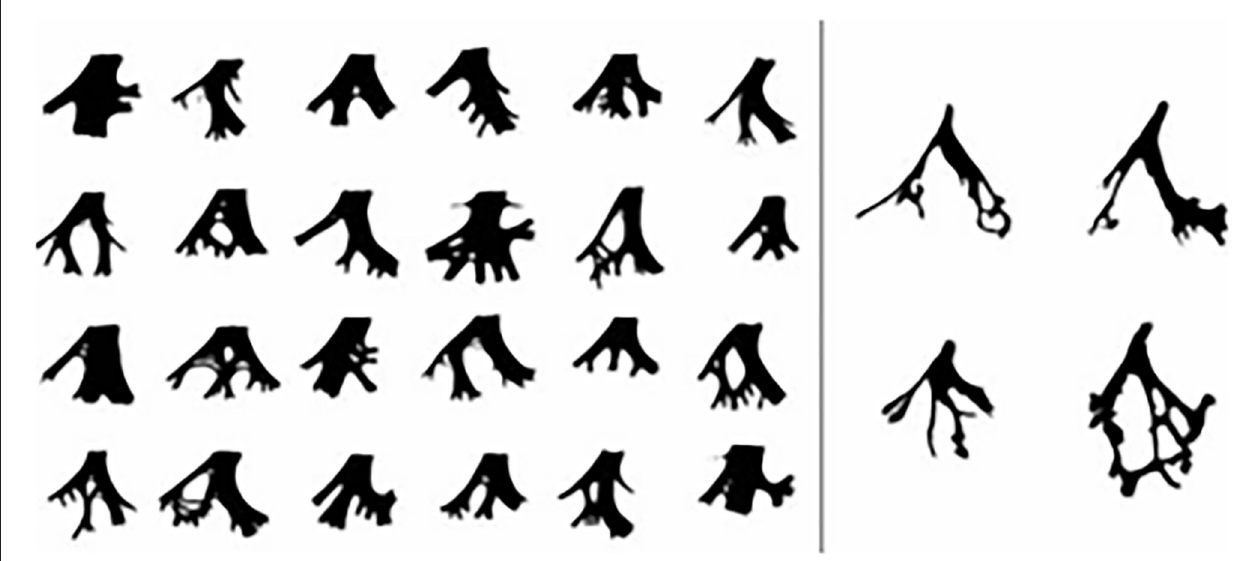
FIGURE 1 | The anatomy type of LBB and its divisions Left, Diagrammatic sketches of the LBB. Right, 4 prototypes of